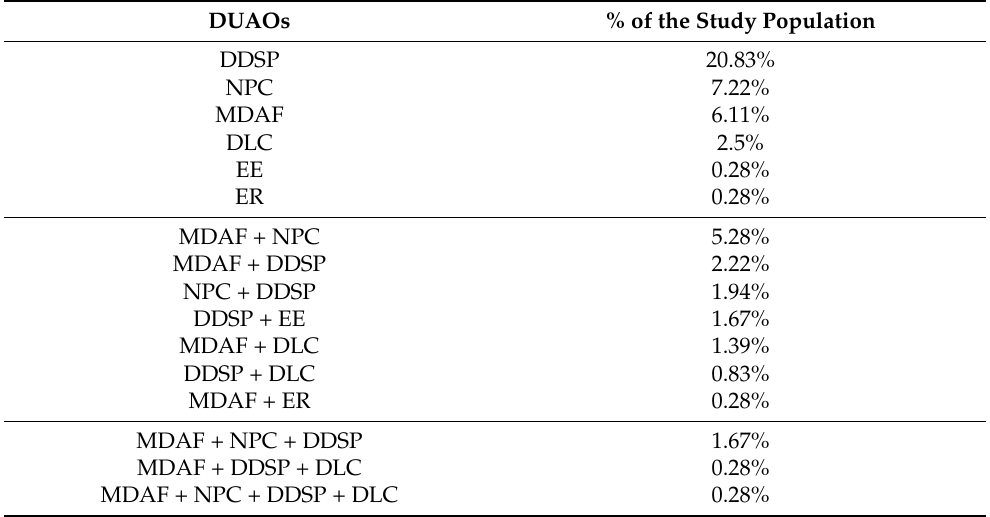
Table 3. Frequency of single or multiple dynamic upper airway obstructions (DUAOs) de- tected during high-speed treadmill endoscopy. DDSP = dorsal displacement of the soft palate; NPC = nasopharyngeal collapse; MDAF = medial deviation of aryepiglottic folds; DLC = dynamic laryngeal collapse; EE = epiglottis entrapment; ER = epiglottis retroversion. DUAOs